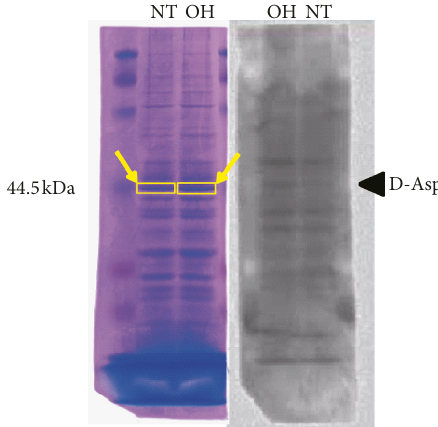
Figure 3: Preparation for identification of proteins including D- aspartic acid in the retinas of rats with ocular hypertension and normal tension. The target bands (yellow arrow), adjusted by western blotting ( right panel ), were cut out from gels staining with Coomassie Brilliant Blue ( left panel ) to prepare for